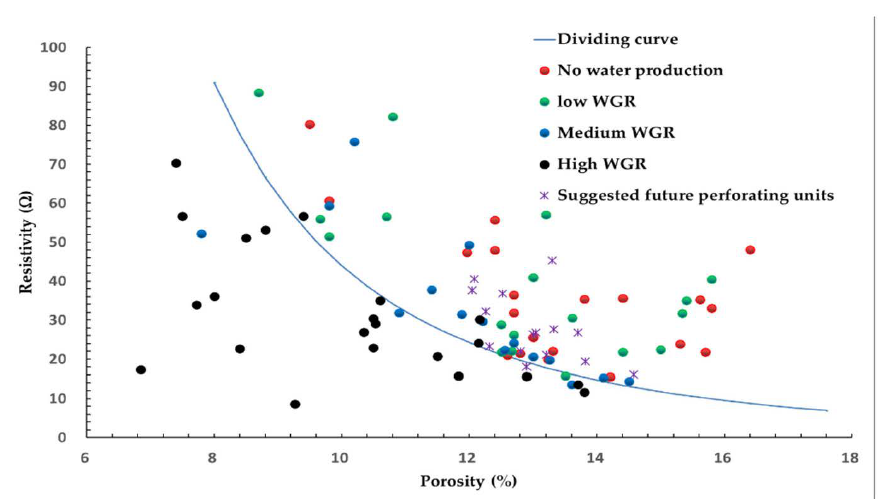
Figure 12. WGR of gas well corresponding to well logging interpreted porosity and